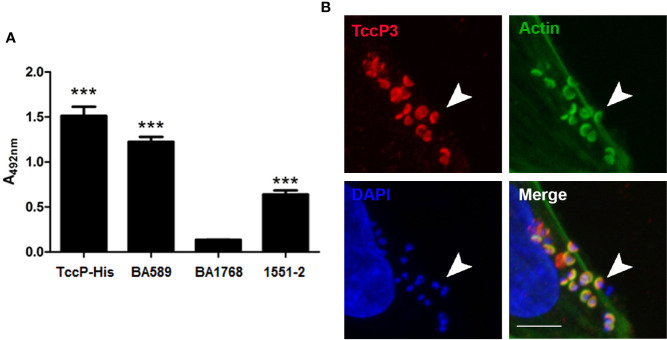
Evaluation of TccP3 production and colocalization with F-actin accumulation underneath adherent E. albertii 1551-2 strain. (A) Detection of TccP3 production by the 1551-2 strain by ELISA. The recombinant protein TccP-His and atypical EPEC BA589 (TccP2+) were used as positive controls, while the atypical EPEC strain BA1768 (TccP-/TccP2-) was used as a negative control. ***p < 0.001. (B) HeLa cells were incubated with E. albertii 1551-2 for 6 h, fixed and stained with anti-TccP sera, phalloidin-FITC, and DAPI, then evaluated by confocal microscopy. Actin filaments (green) clearly accumulate underneath adherent bacteria and colocalize (arrowheads) with TccP3 (red). Confocal microscopy image of a single focal plane; DAPI (blue), scale bar = 5 μm.